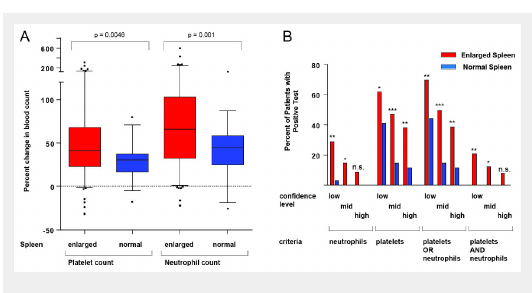
Changes in spleen size and peripheral blood count during epinephrine stimulation test (EST). Peripheral blood count and spleen pole diameter were determined before and at 30 min or 10 min following epinephrine injection respectively. The box plot indicates the median and the 25 th and 75 th percentile of the data respectively. The whiskers represent the 5 th and 95 th percentile; outliers are directly shown. Statistical analysis: Wilcoxon signed rank test.